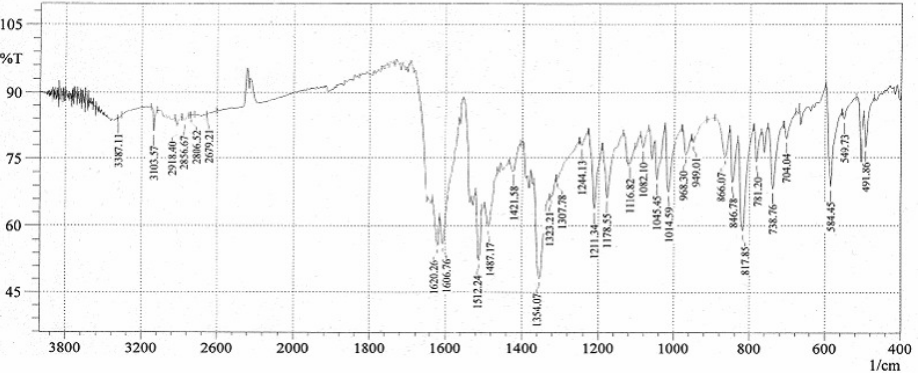
Figure 8. FT IR spectra of